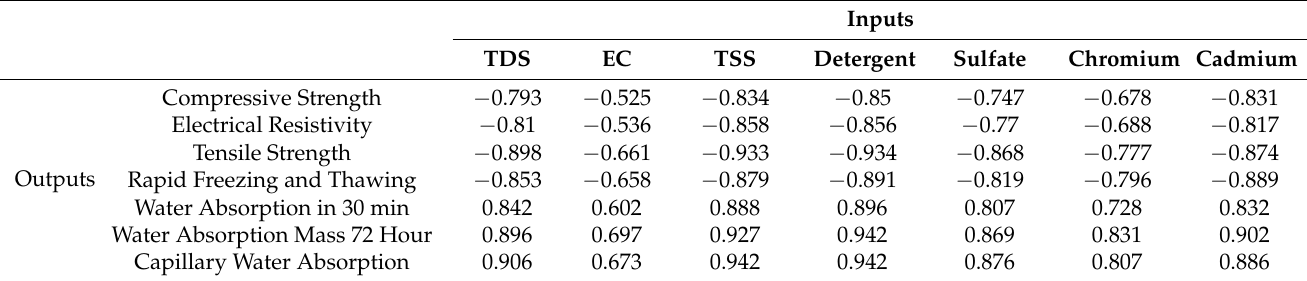
Table 11. Pearson correlation coefficients between inputs and outputs in this